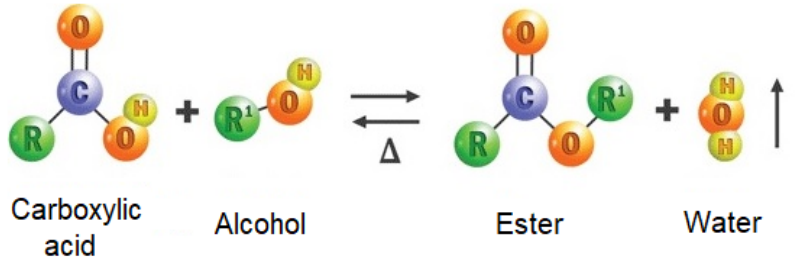
Figure 1. Graphical presentation of the esterification mechanism.